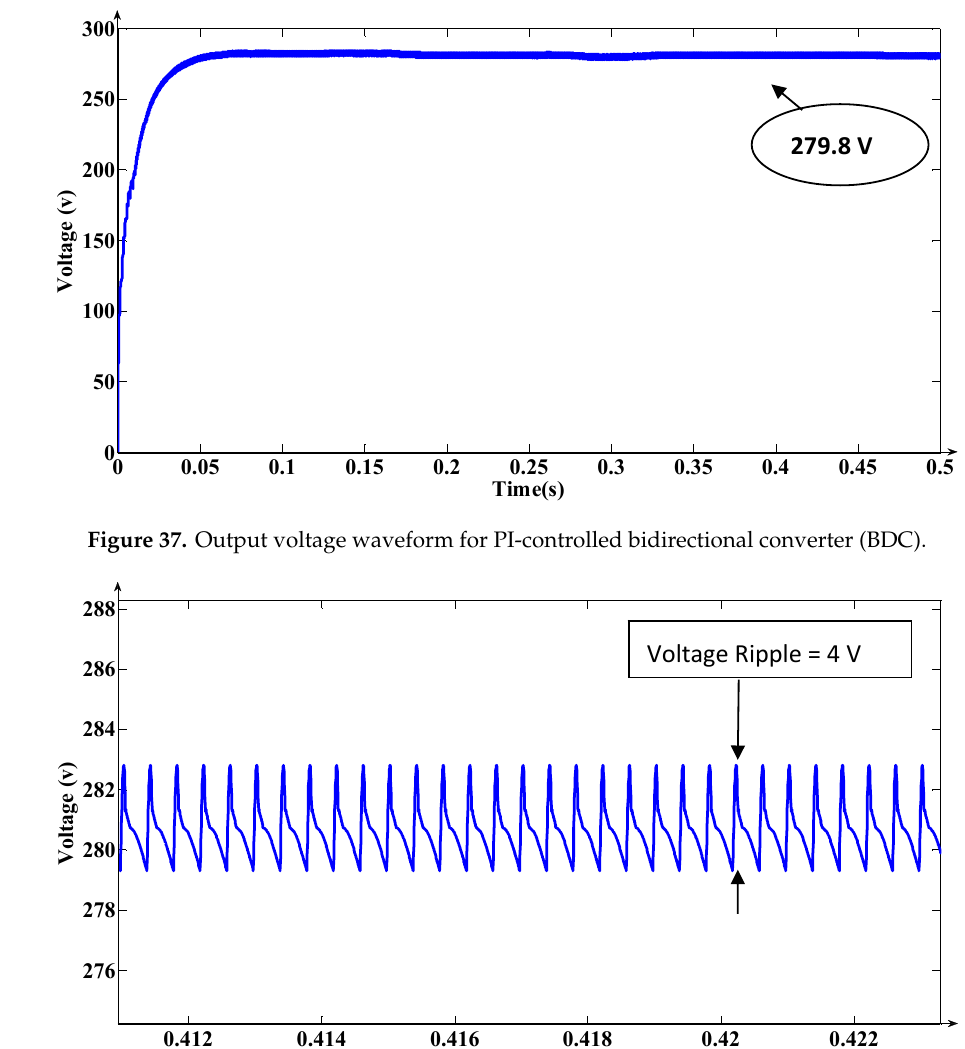
Electronics 2019 , 8 , 1092 Figure 38. Ripple waveform for output voltage of PI-based BDC. Figure 38. Ripple waveform for output voltage of PI-based BDC.